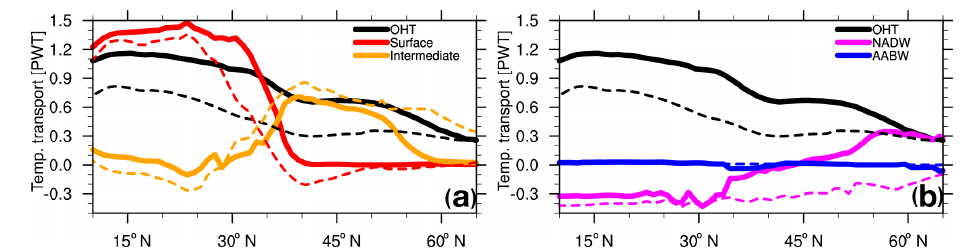
Figure A2. (a) Time-mean temperature transport in the surface layer (red) and intermediate layer (yellow, in PWT) compared to the total OHT (black) and (b) time-mean temperature transport in the North Atlantic Deep Water (NADW, magenta) and Antarctic Bottom Water (AABW, blue) (in PWT) compared to the total OHT. The historical simulation (1850–1950) is shown by solid lines, RCP 8.5 (2200–2300) by dashed